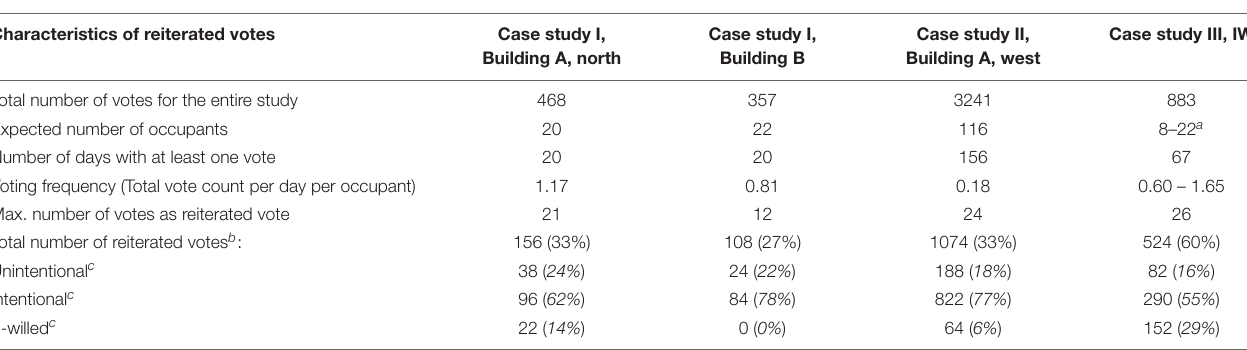
FIGURE 6 | Relative frequency distribution of the common logarithm of the timespan between two votes for case I, II, and III. The bandwidth used for generating the plot was 0.20 s. TABLE 2 | Voting frequency and count of reiterated votes for each case